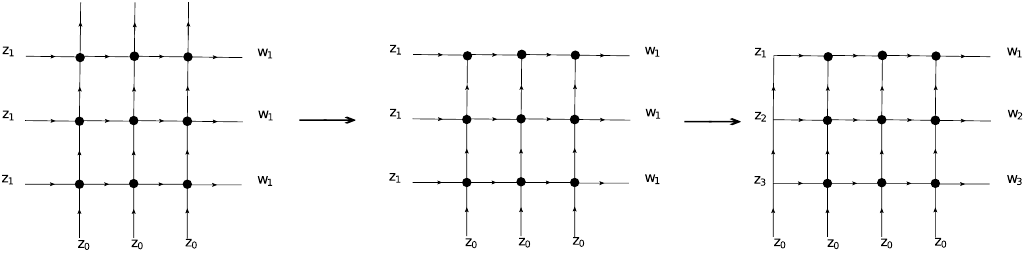
Figure 2 . Basso-Dixon type diagram I BD (in the middle) and generalization D L;N ( z only the coordinates in the vertices marked by black blobs. Sending w 0 Dixon type diagram, we remove the upper row of propagators and obtain the reduced diagram (in the middle). Using conformal invariance of the original graph (on the left), we can always restore it from the graph on the right, by inversion and shift of coordinates w 1 ; z 1 ; z 0 . Further on, we generalize the middle diagram by splitting the end point coordinates of left and right columns of external propagators, to separate coordinates z 1 and then add at the left a column of vertical propagators [ z i con(cid:12)guration (on the